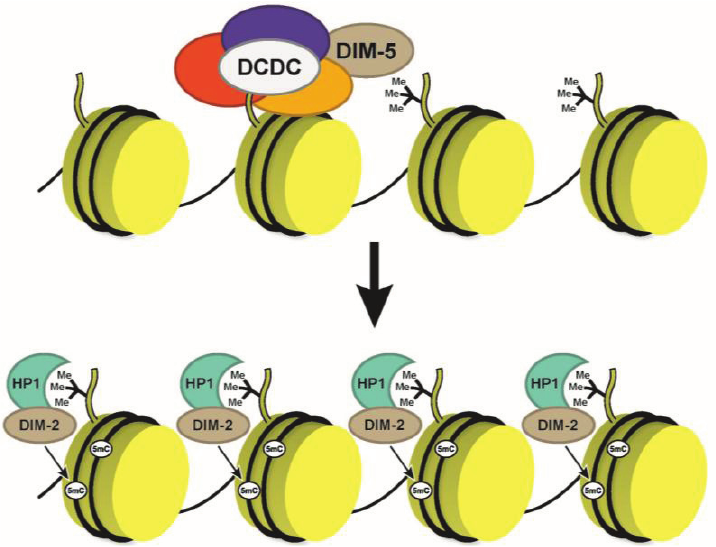
Figure 3. DNA methylation in Neurospora . The current model for DNA methylation in Neurospora suggests a multistep process that starts with DIM-5 recruitment and H3K9 methylation mediated by the DCDC complex. Once the H3K9me3 is established, HP1 in association with DIM-2 and binds to H3K9me3 via its chromodomain, and then, DIM-2 catalyzes